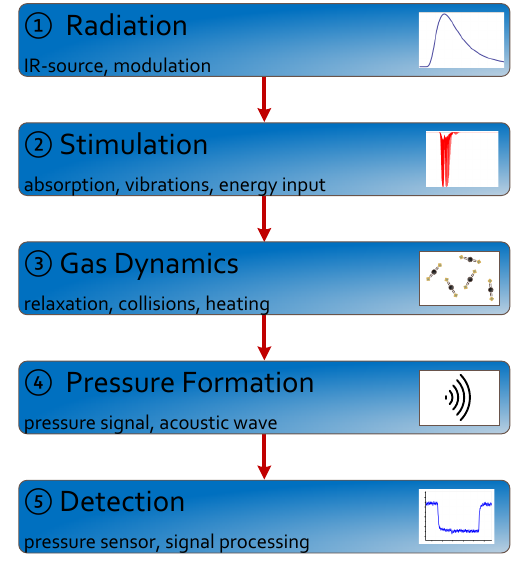
Figure 1. Visualization of the formation of a photoacoustic wave in five